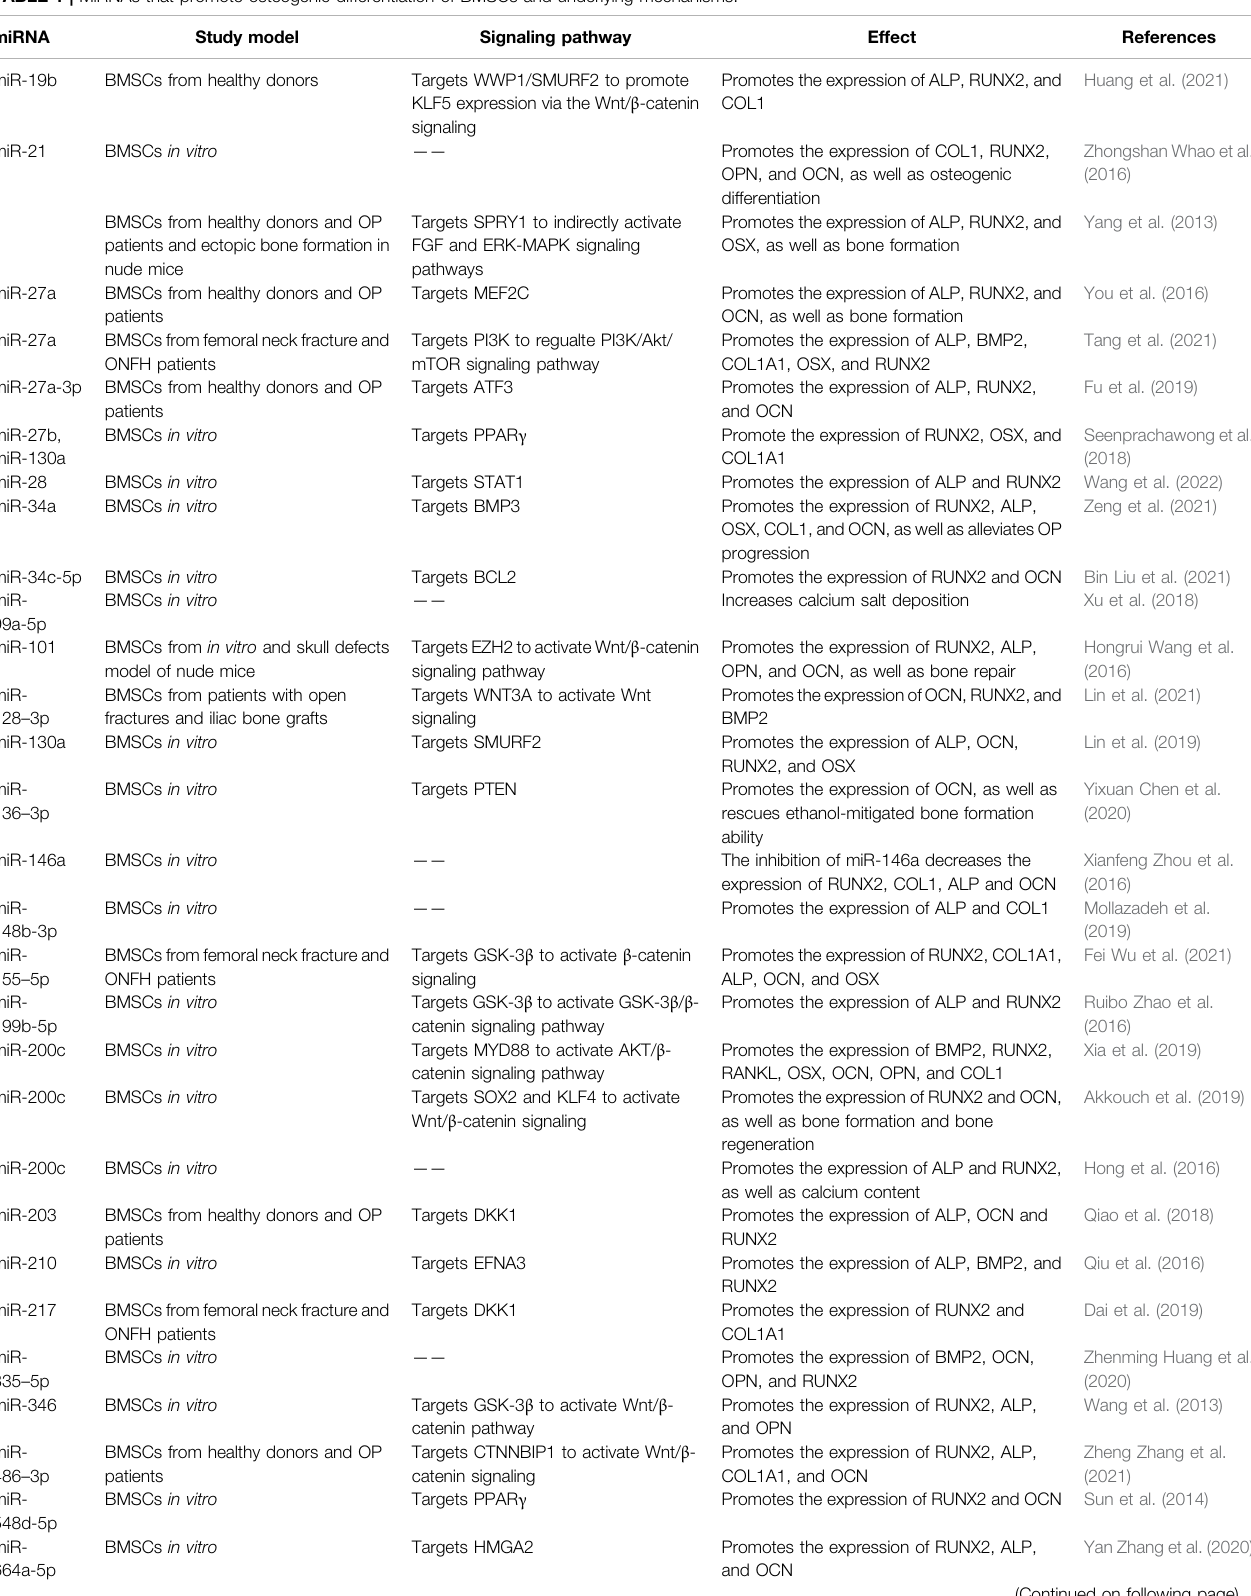
TABLE 1 | MiRNAs that promote osteogenic differentiation of BMSCs and underlying